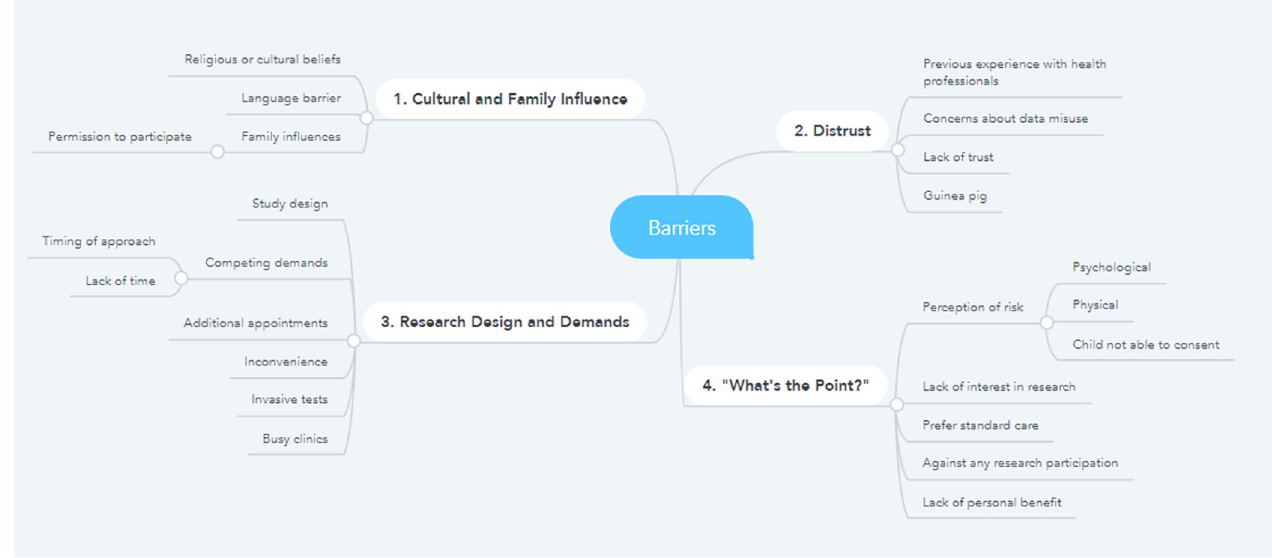
Fig 2. Thematic maps of barriers and